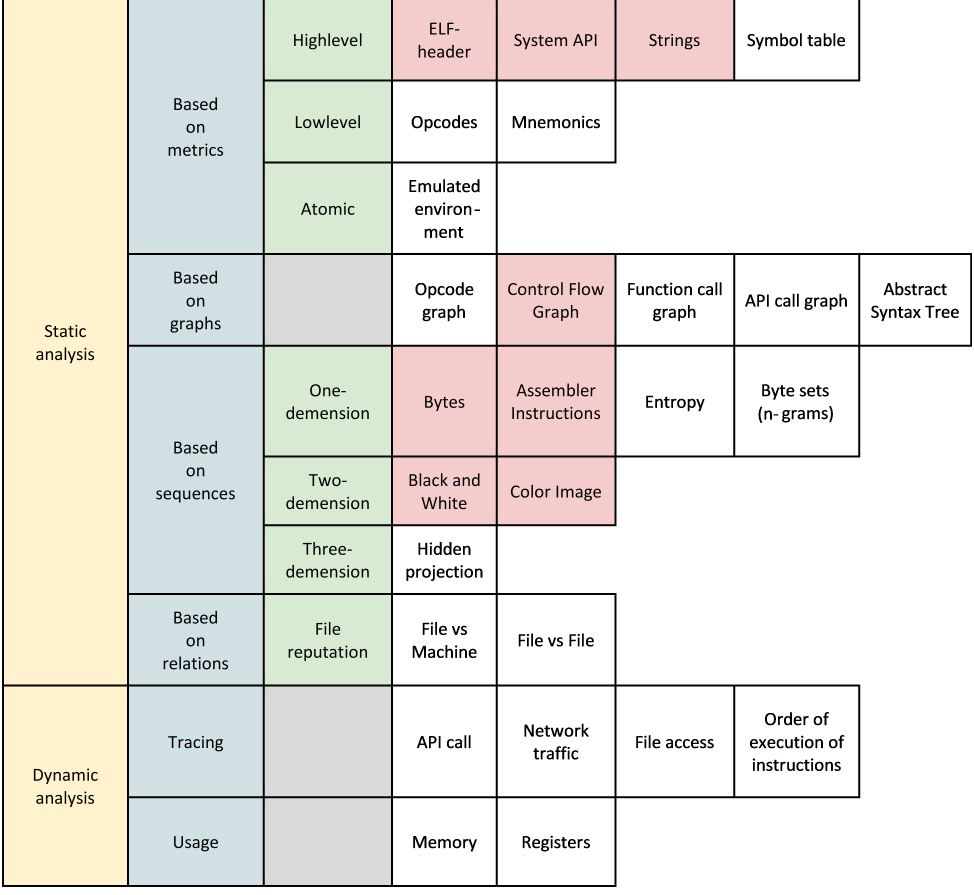
Figure 1. Taxonomy of features for binary code analysis methods. Note. The following cell back- ground colors are used: yellow—1st level subgroup, blue—2nd level subgroup, green—3rd level subgroup, gray—3rd level subgroup is absent (according to the original taxonomy), red—presence of the CAF property, white–other